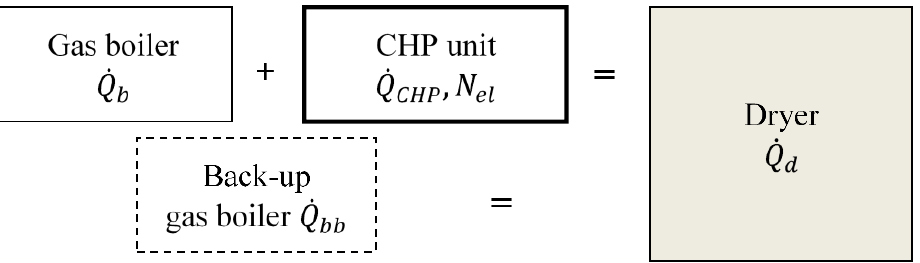
Figure 3. Heat source configuration applied for the analyzed sewage sludge dryer.